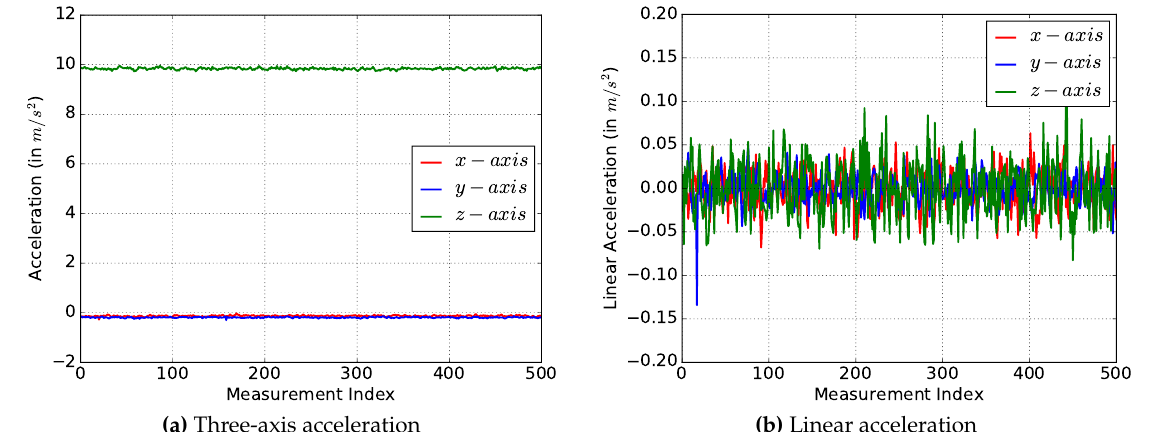
Figure 6. Acceleration